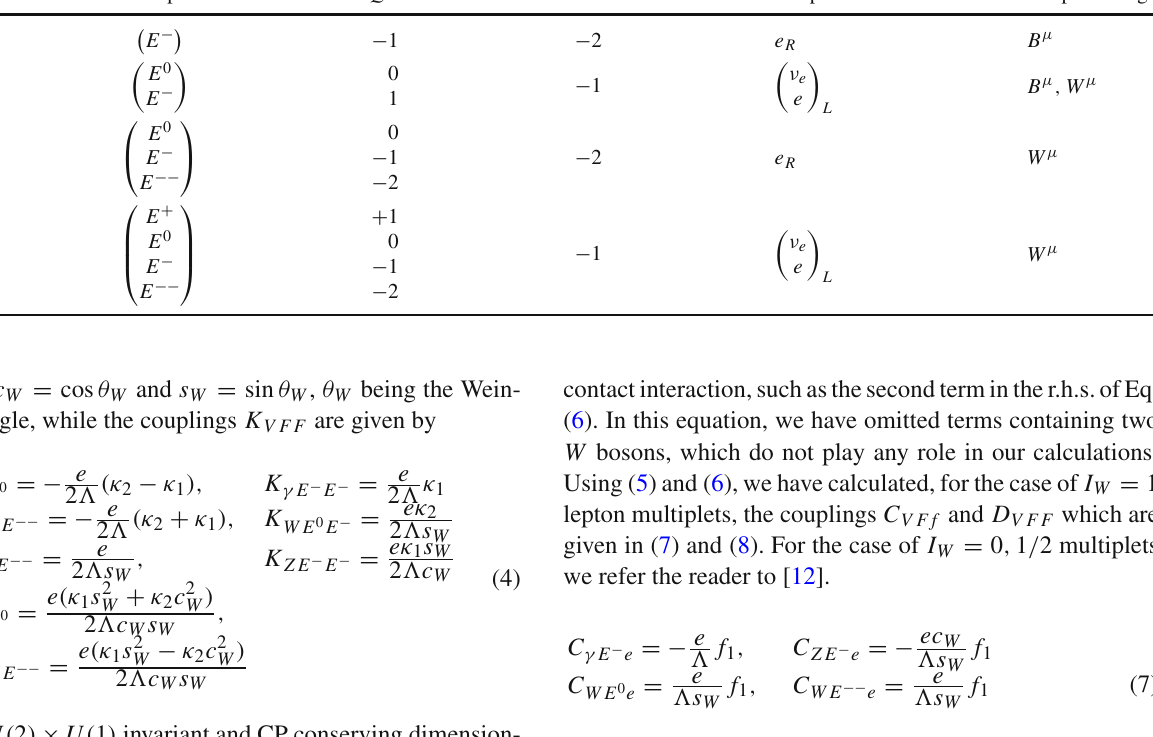
Table 1 Lepton multiplets for I W = 0 , 1 / 2 , 1 , 3 / 2 , their charge Q , hypercharge Y and the fields through which they couple to ordinary leptons I W Multiplet Q Y Couple to Couple